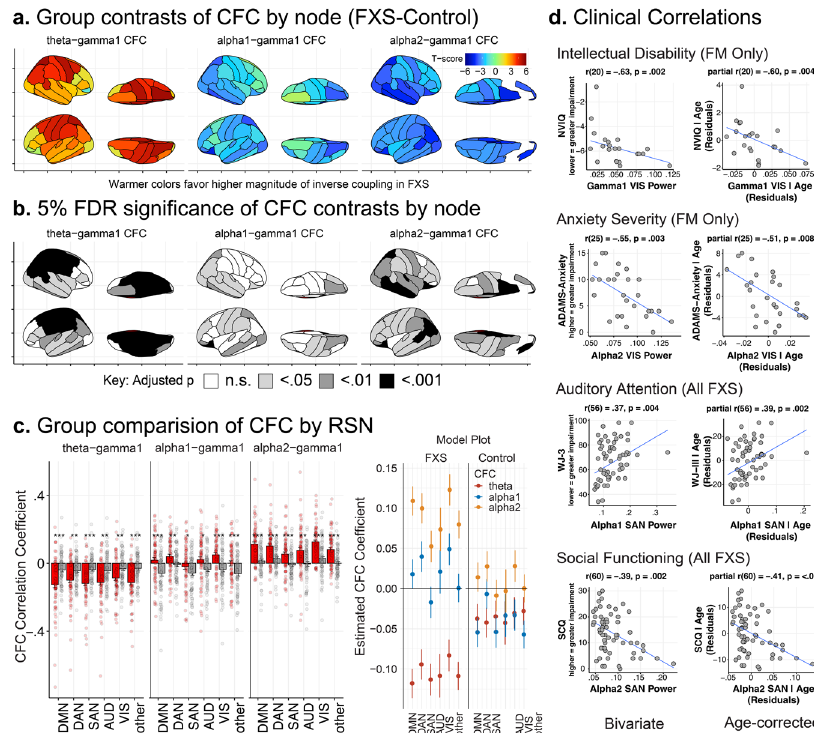
Fig. 5 The power-power cross-frequency coupling (CFC) between theta power and gamma power in TCD syndromes is stronger than that between alpha power and gamma power. a Brain atlas heatmaps depict group-level differences (t-values) between CFC. Since CFC coef fi cients can represent either a direct or inverse relationship between frequencies, the higher the t values, the greater the difference in the magnitude of the coupling. Participants with FXS ( n = 70) showed a signi fi cantly higher magnitude of inverse theta-gamma1 CFC compared to controls ( n = 71), especially over the parietal and central regions. b Brain atlas plots with shaded areas representing 5% FDR-corrected signi fi cance of pairwise contrasts. c Bar plots of mean ± standard error of least-squared mean estimates (with superimposed subject-level data) of CFC by RSN. Asterisks signify signi fi cant mean differences between FXS (red) and control (gray) groups. An accompanying mean ± standard error model plot of group by CFC type across RSN demonstrates a prominent increase in inverse theta-gamma1 CFC and an increase in direct alpha2-gamma CFC in the FXS group. d Exemplar clinical correlations with EEG variables across all FXS subjects and a subgroup of full mutation, non-mosaic males (FM). Scatterplots in each quadrant depict subject-level bivariate and age-corrected